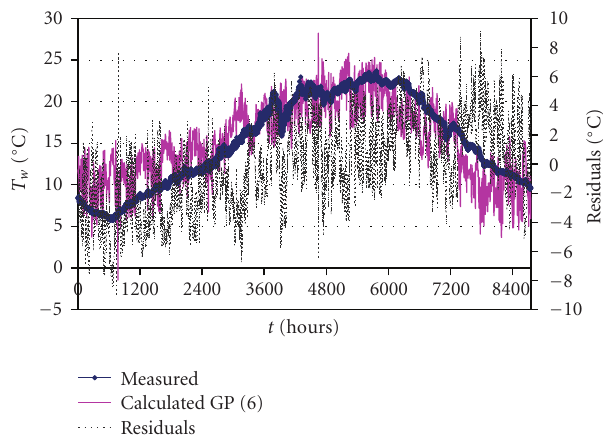
Figure 3: Water temperature values and residuals, experiment without standardization (hourly average